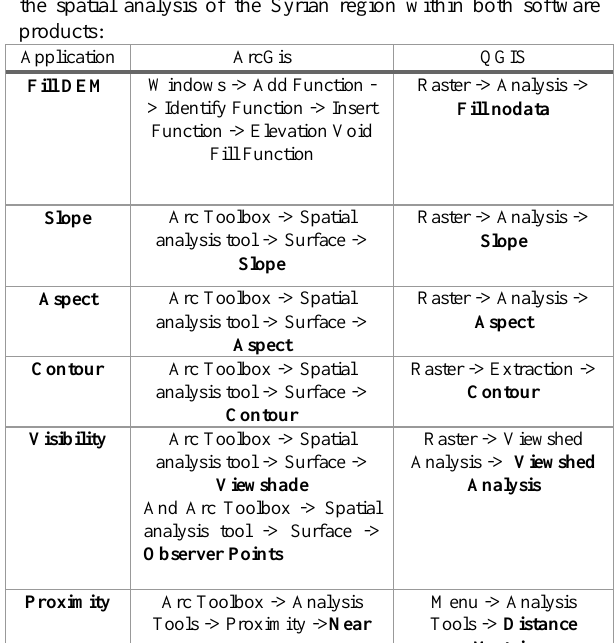
Table 3. Commands in ArcGis and